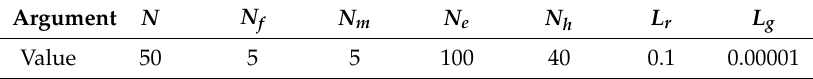
Table 2. The values of parameters of the machine learning (ML)